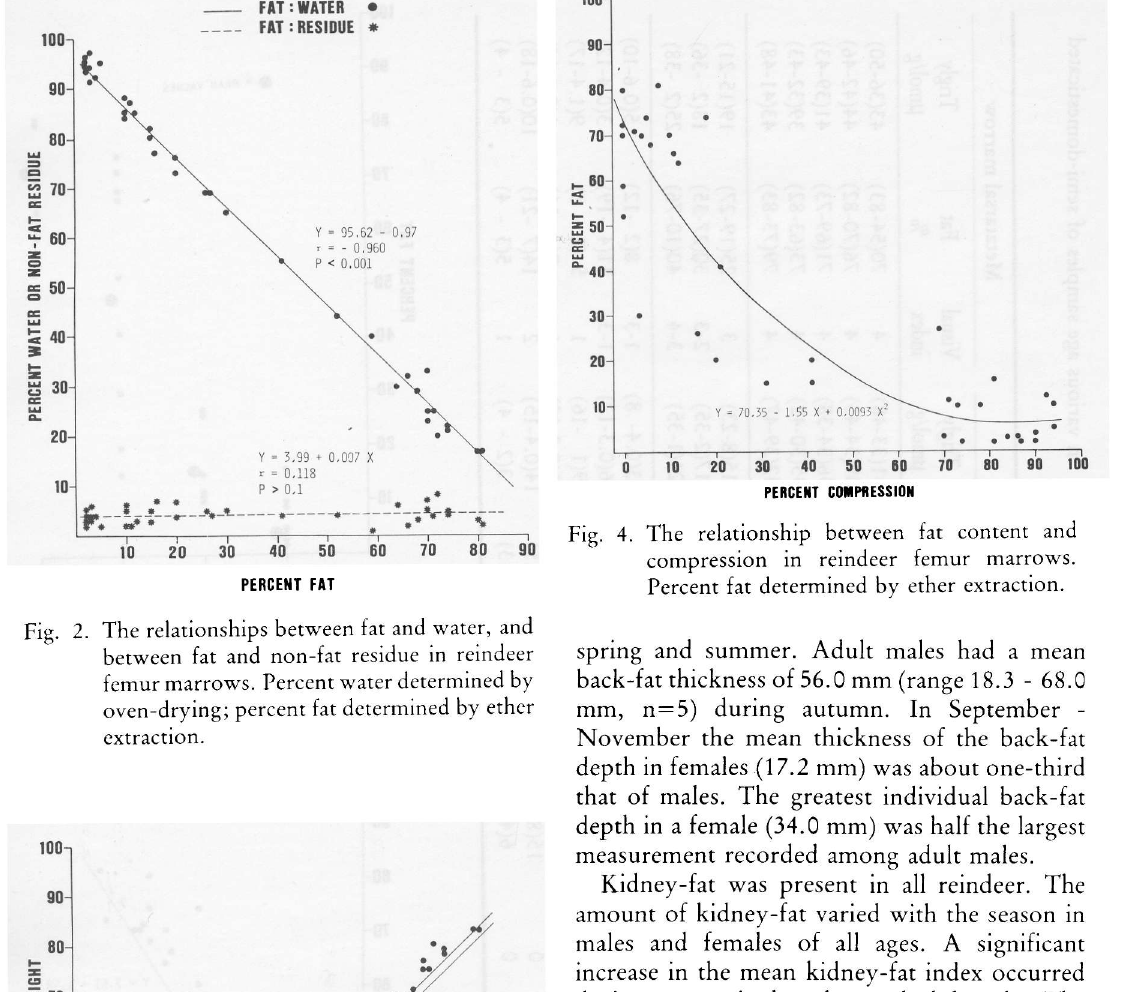
Fig. 4. The relationship between fat content and compression in reindeer femur marrows. Percent fat determined by ether